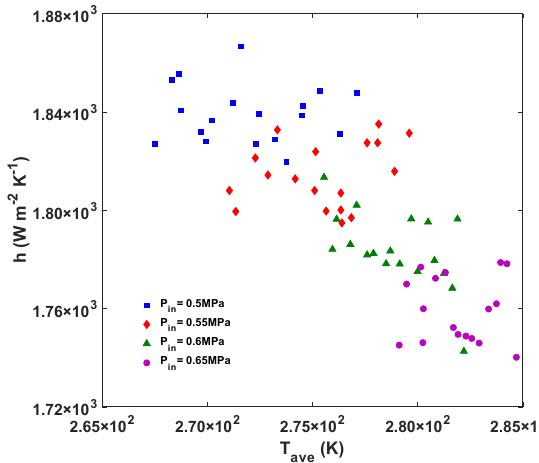
Figure 7. Heat transfer coefficient of the R22 versus the average temperature under different pressures for G = 10.52 kg m - 2 s - 1 .